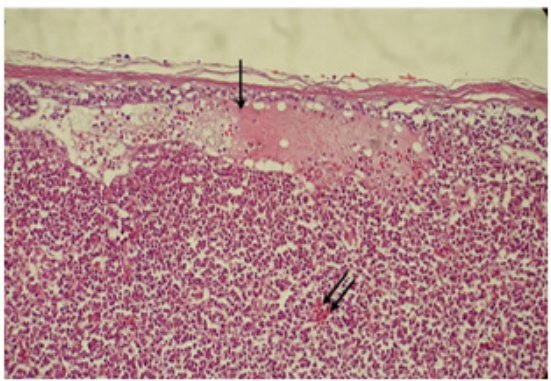
Figure 4: Photomicrograph showing muscle tumour (arrow) due to Marek’s disease along with focal pleomorphic cell proliferation (double arrow) (× 200).